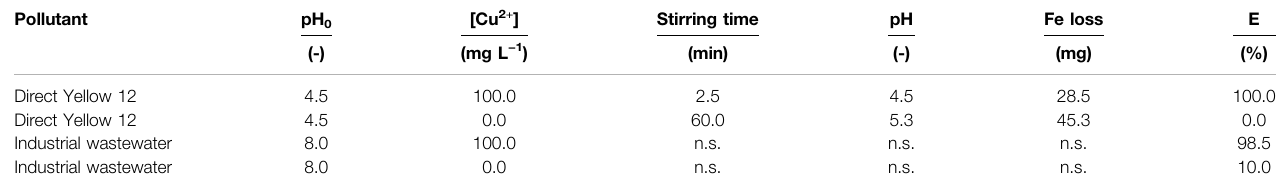
TABLE 2 | Summary of experimental conditions and results for the Fe0/H2O systems investigated by Khudenko (1991). pH0 (cid:1) initial pH, [X] (cid:1) concentration of X, pH (cid:1) fi nal pH, E (cid:1) per cent removal ef fi ciency, n.s: not speci fi ed. Pollutant